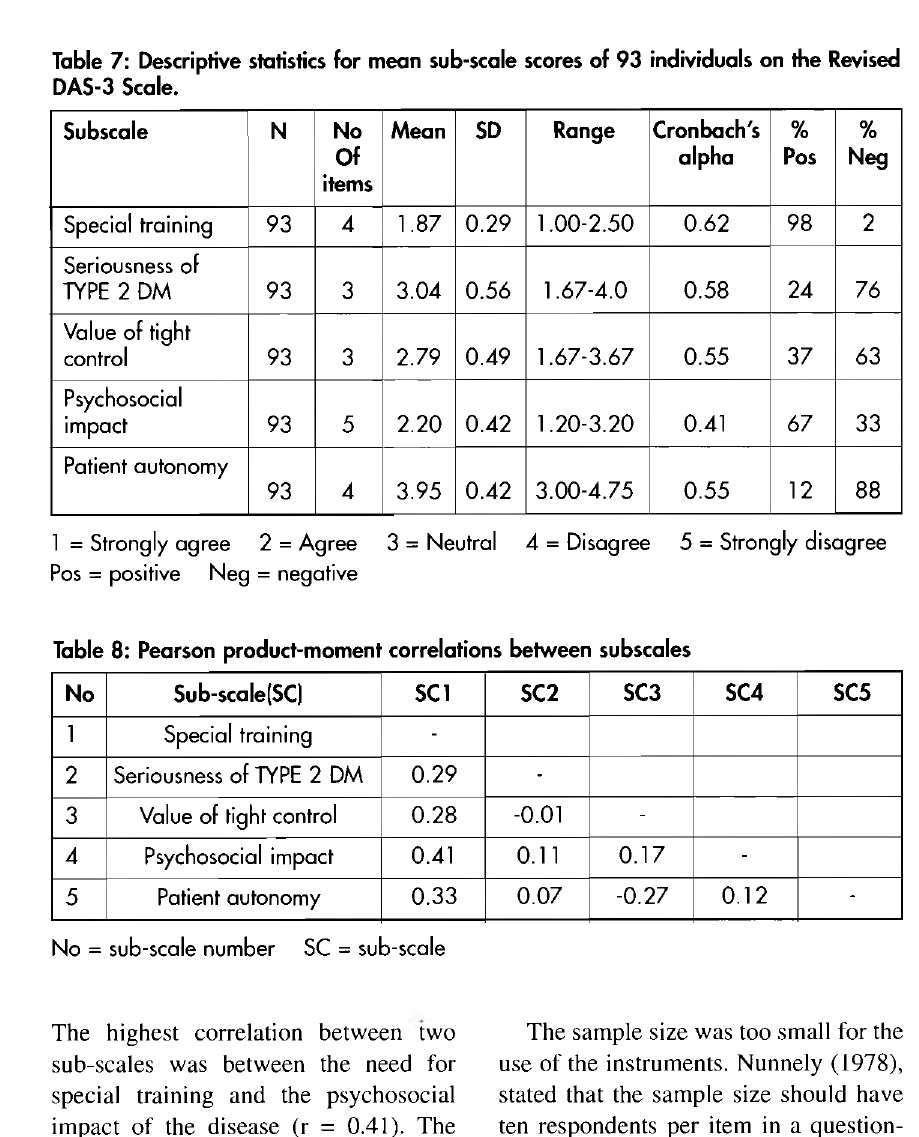
Table 8: Pearson product-moment correlations between subscales